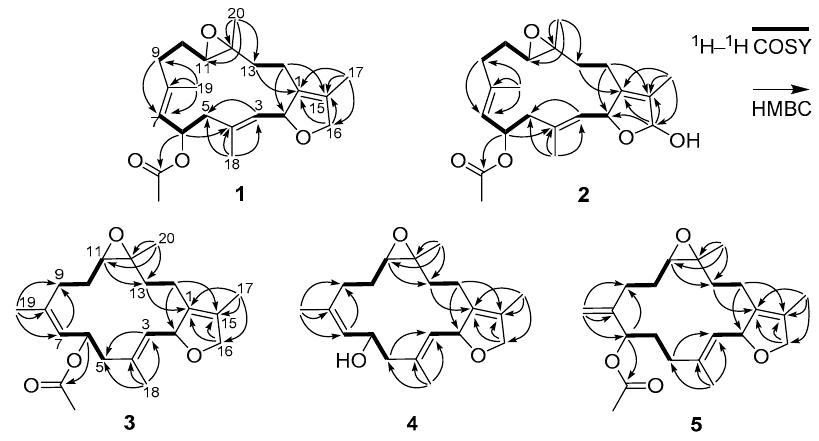
Figure 2. The 1 H- 1 H COSY and selected HMBC correlations of compounds 1 – 5 .